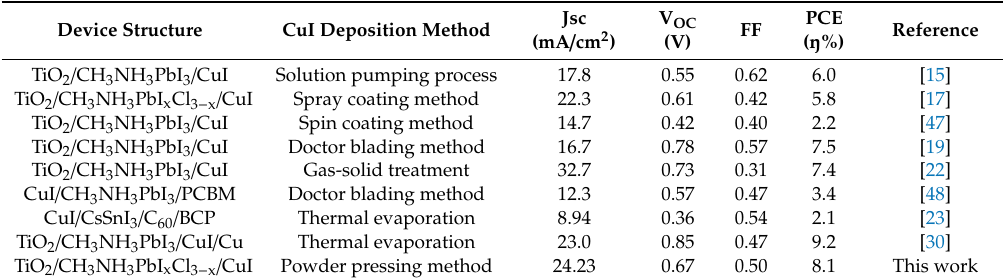
Figure 4. Proposed energy band diagram for the fabricated PSCs. Table 2. Comparison of perovskite solar cells (PSCs) reported in the literature with CuI as the hole transporting material fabricated by different techniques.